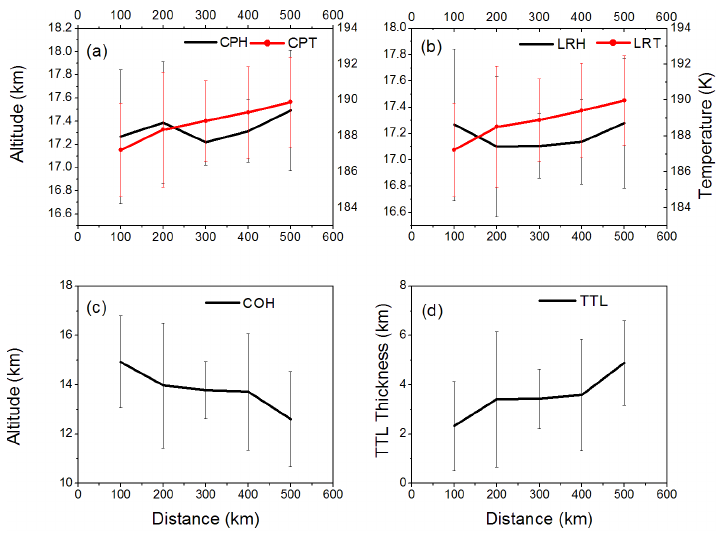
Figure 8. Variability in the tropopause parameters of (a) CPH and CPT, (b) LRH and LRT, (c) COH, and (d) TTL thickness observed within 500km from the centre of the TC. Vertical bars show the standard